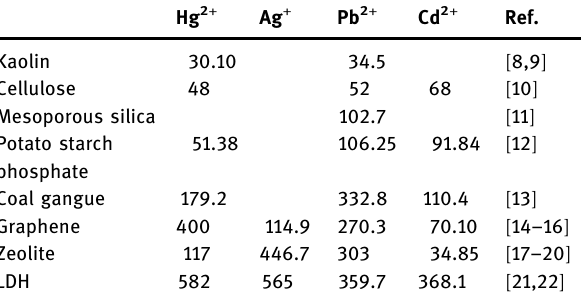
Table 1: Absorption capacity ( mg/g ) of di ff erent absorption materials for heavy metal